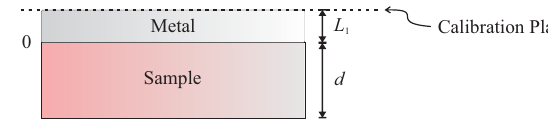
Figure 5. Representation of the ticknesses d and L 1 , which are used to adjust the